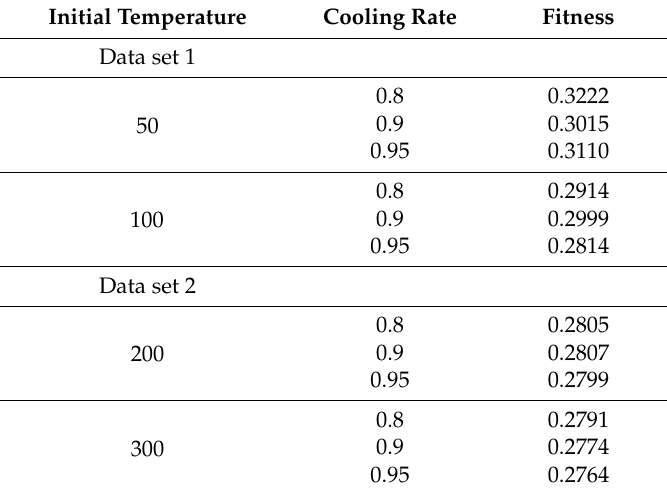
Table 2. Best initial temperature for simulated annealing (SA).